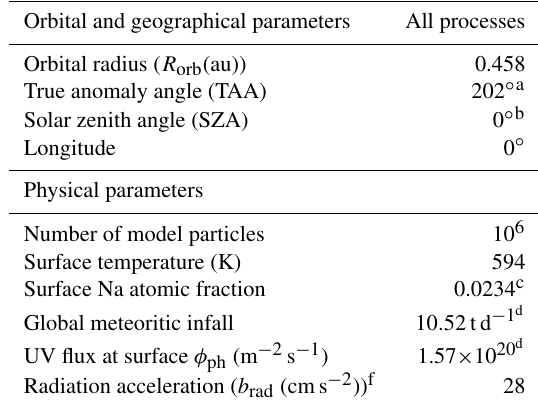
Figure 1. Normalized energy distribution functions for several release mechanisms active on Mercury’s surface to produce the sodium exosphere. The vertical solid line marks the value at which sodium atoms have enough energy to escape the gravitational field of Mercury.